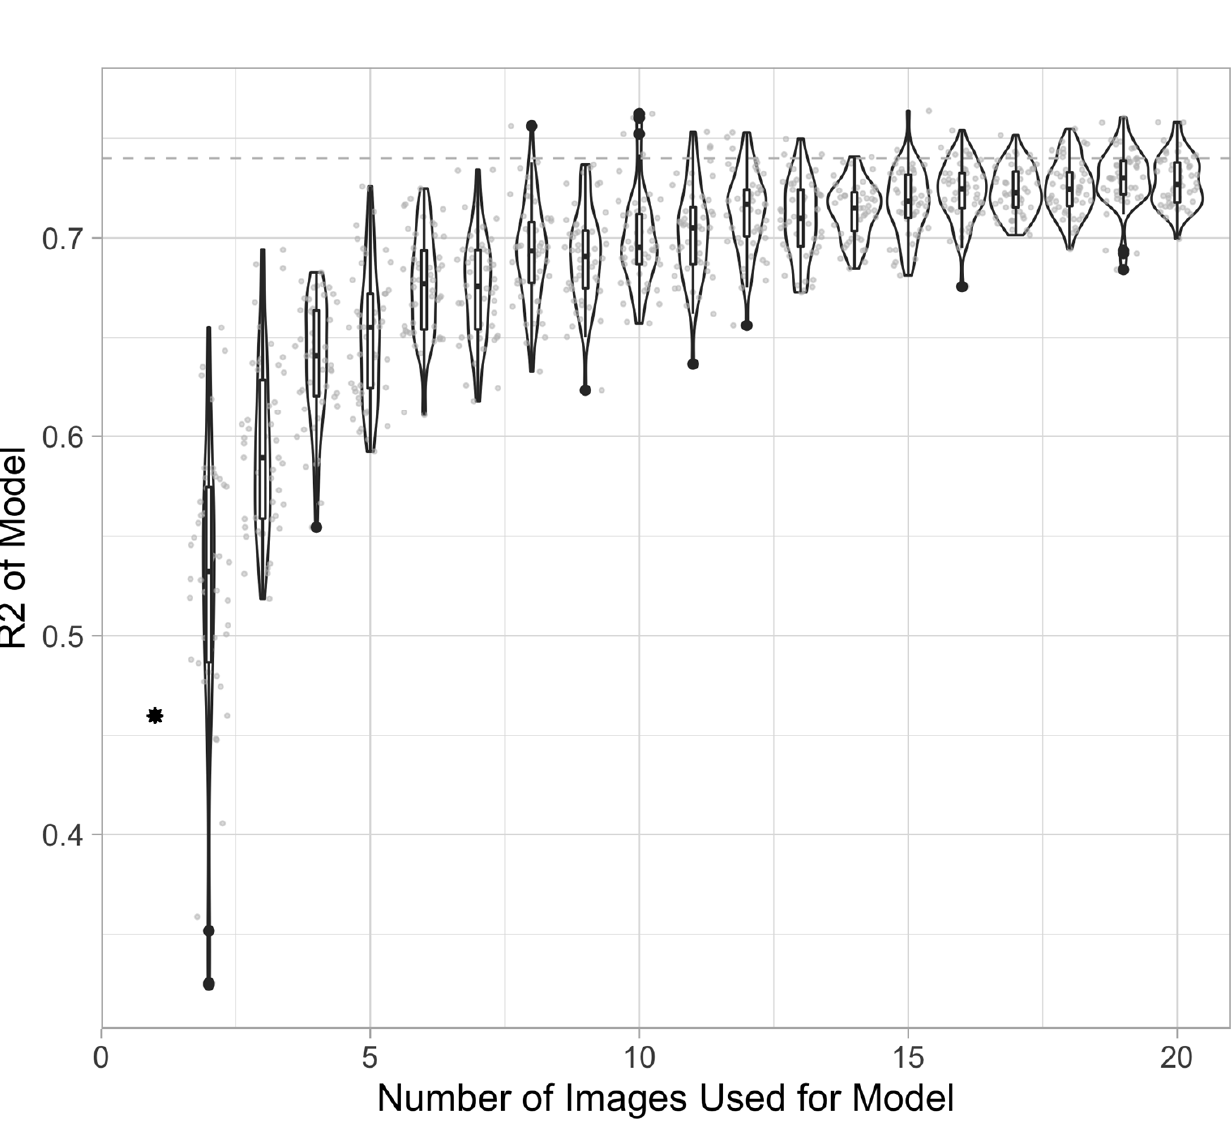
Figure 6. Overall adjusted R 2 over number of images used for CDOM( a 440 ) estimation. Grey points represent adjusted R 2 values for a given number of images; violin plots show overall densities of the data for a given number of images; the dashed line represents the estimated asymptote; the black star represents adjusted R 2 using a single image closest in time to when in situ sampling took place.